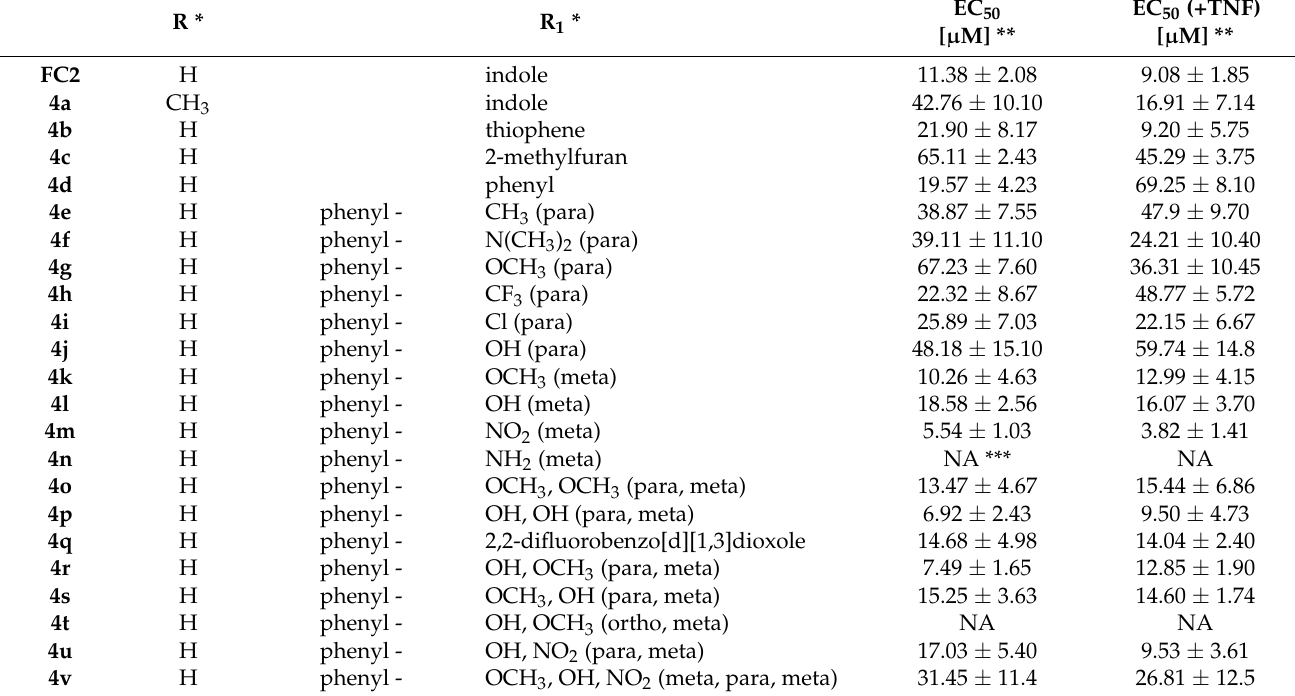
Table 1. Cell viability of MDA-MB-231 upon treatment with FC2 and FC2 derivatives.